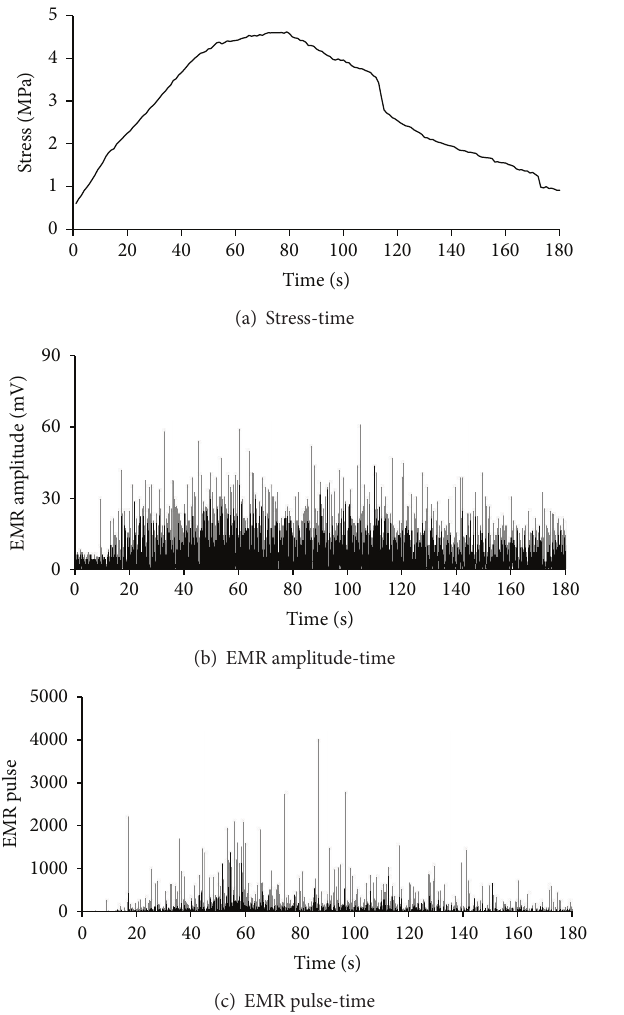
Figure 6: The measured stress and EMR of LM4# coal sample. Figure 7: The measured stress and EMR of LM5# coal sample.